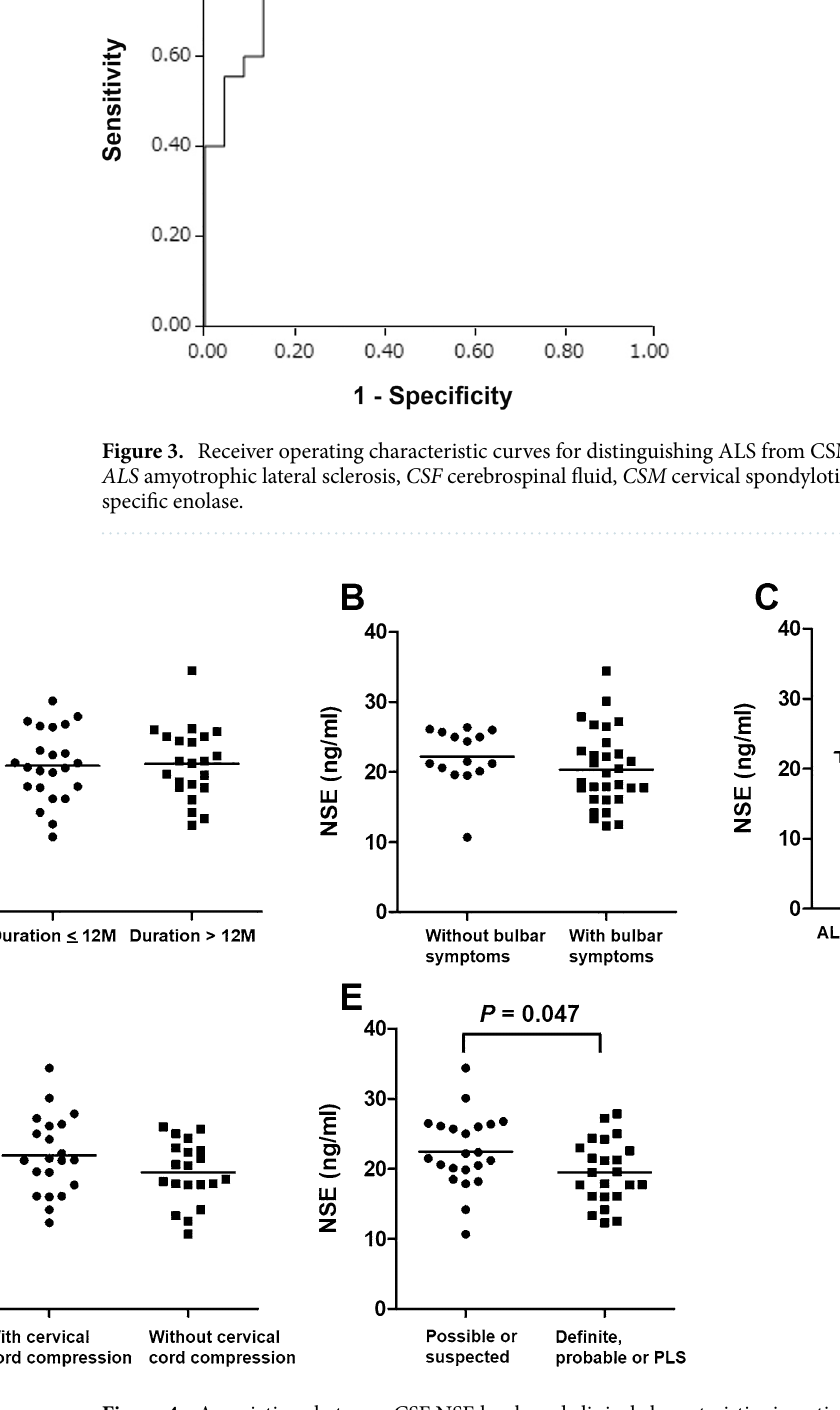
Figure 4. Associations between CSF NSE levels and clinical characteristics in patients with ALS at the time of CSF sampling. The CSF NSE levels of patients ( A ) with a disease duration of ≤ 12 and > 12 months, ( B ) those with and without bulbar symptoms, ( C ) those with an ALSFRS-R score of > 36 and ≤ 36, ( D ) those with and without cervical cord compression on MRI, and ( E ) those with possible or suspected ALS and definite, probable, or PLS ALS. The solid line represents the mean CSF NSE levels of each group. ALS amyotrophic lateral sclerosis, ALSFRS-R revised ALS functional rating scale score, CSF cerebrospinal fluid, CSM cervical spondylotic myelopathy, NSE neuron-specific enolase, PLS probable